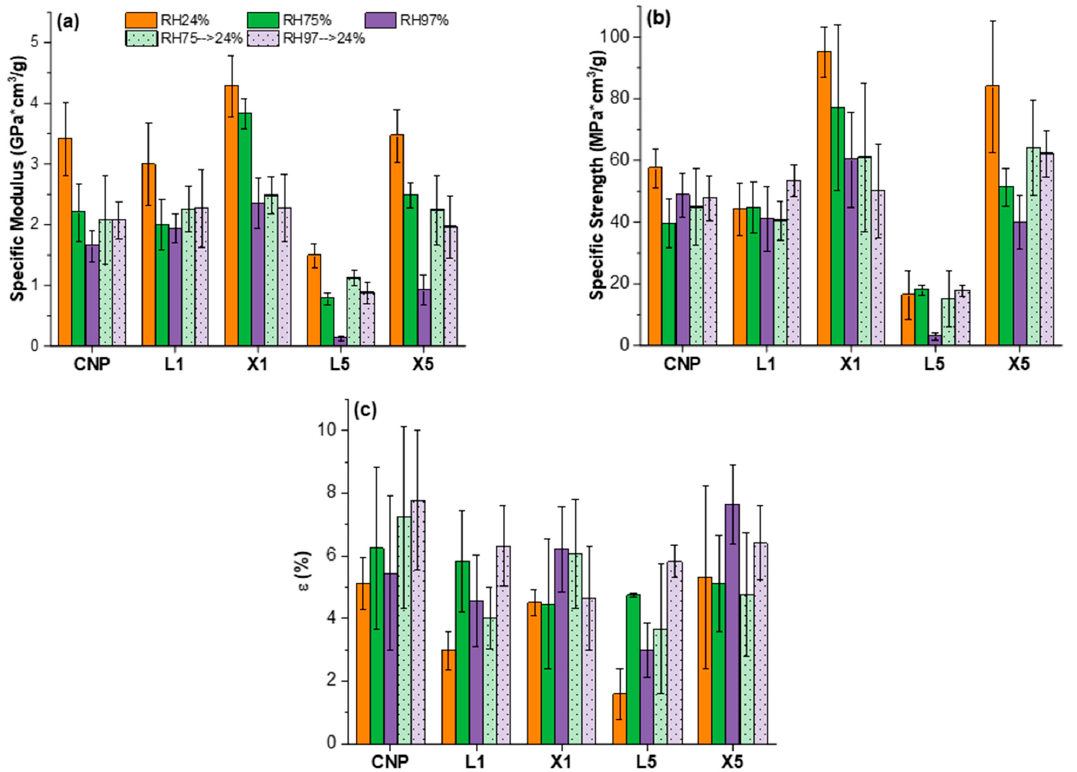
Figure 11. Tensile properties: ( a ) specific elastic modulus, ( b ) specific ultimate tensile strength, and ( c ) elongation at break of CNP, L1, L5, X1, and X5 NPs at different RH (24%, 75%, 97%) and their properties retention after moisture desorption.